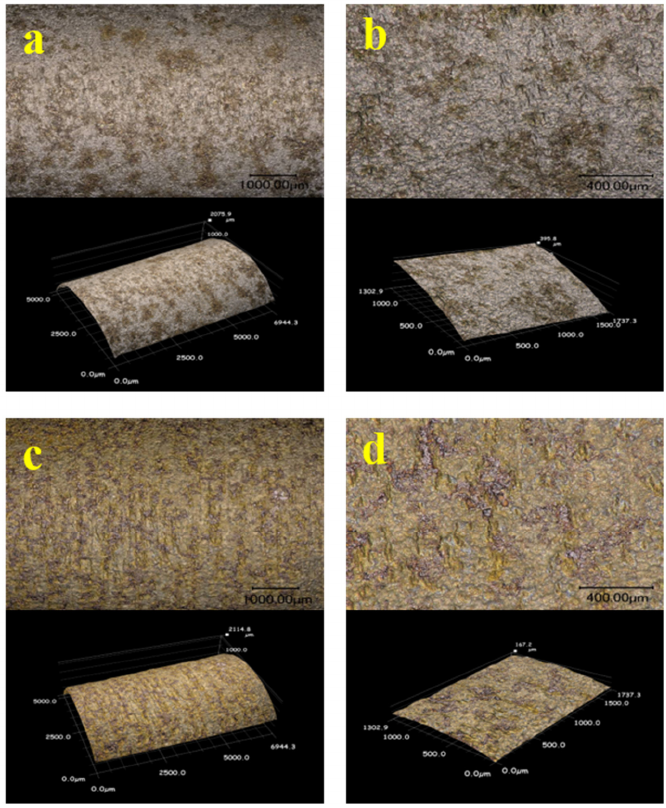
Figure 21. Passive film: ( a ) C110-1, 1000 μ m; ( b ) C110-1, 400 μ m; ( c ) C110-2, 1000 μ m; ( d ) C110-2, 400 μ m.